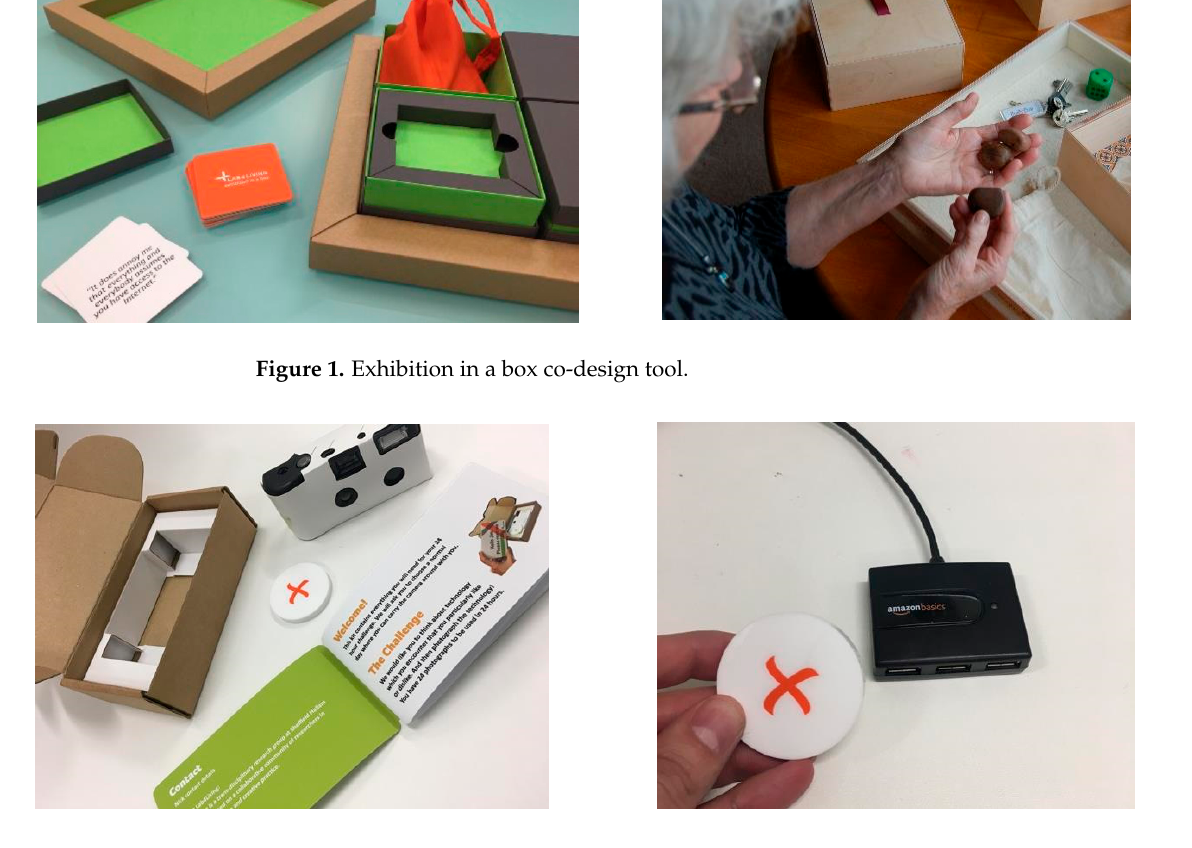
Figure 2. Digital probes co-design tool.